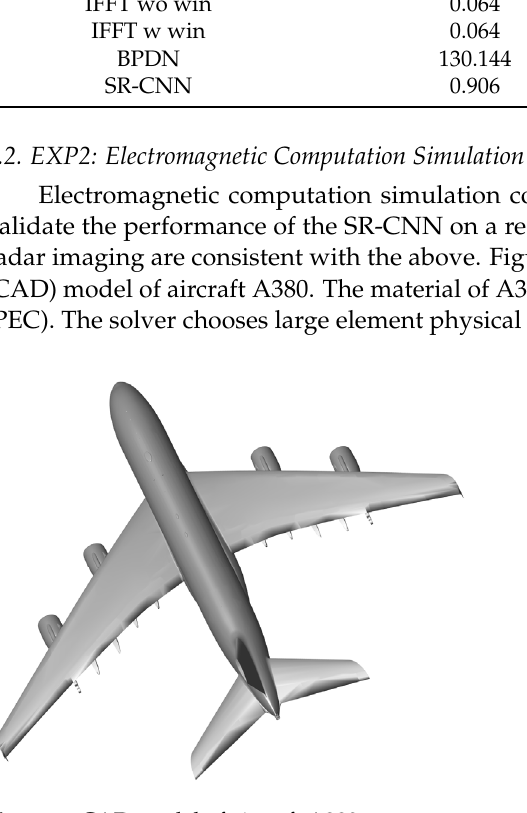
Figure 8. CAD model of aircraft A380.